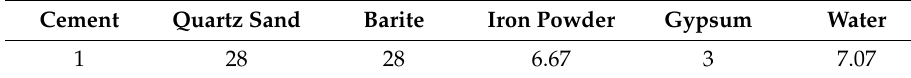
Table 3. The mass proportion of the model rock mass.